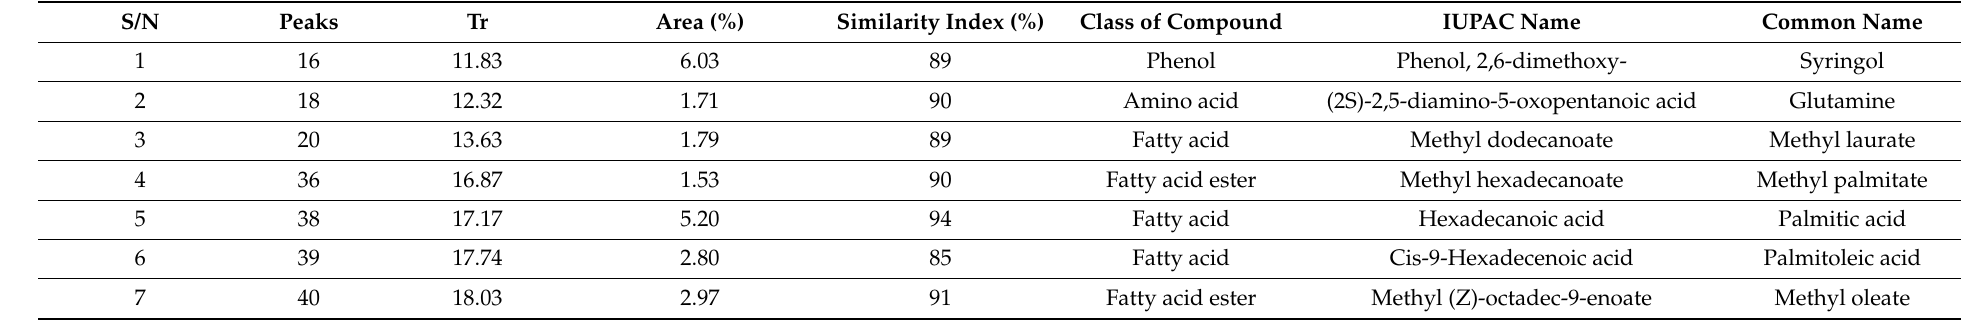
Table 3. Compounds present in the gas chromatography-mass spectrometry (GC-MS) analysis of the unfermented freeze-dried extract of T. catappa .